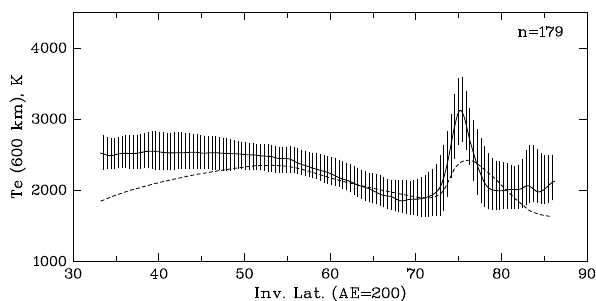
Fig. 4. Mean latitudinal profile of the electron temperature enhance- ment in the dayside polar region in winter. Plotted is the median of 179 temperature profiles which have been superimposed in such a way that the latitude of the temperature peak serves as a com- mon reference location. The shaded area indicates the range be- tween the lower and upper quartiles. The specific latitudes indi- cated on the abscissa apply for an hourly averaged AE index of 200 (see Fig. 2). Also shown is the mean latitudinal profile derived by Titheridge (1976) for similar conditions (dashed line). All temper- atures refer to a common altitude of 600km.